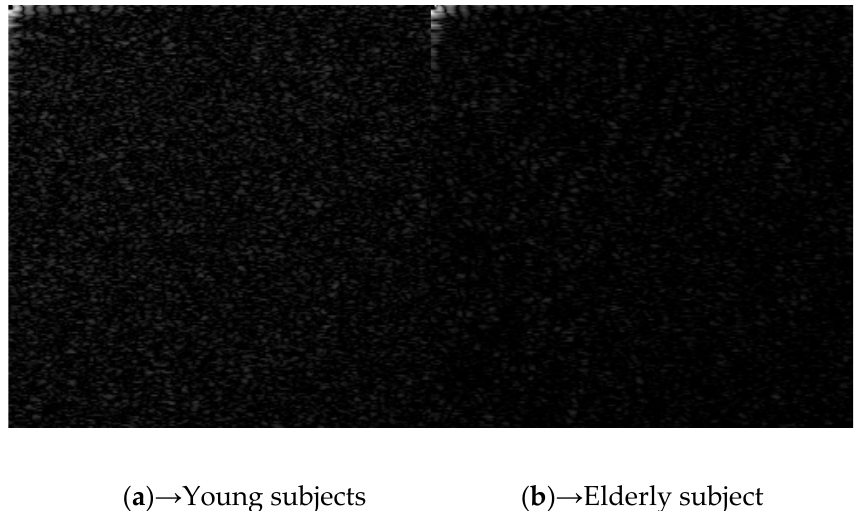
Figure 7. Comparison of ( a ) young (left) and ( b ) elderly (right) subjects.